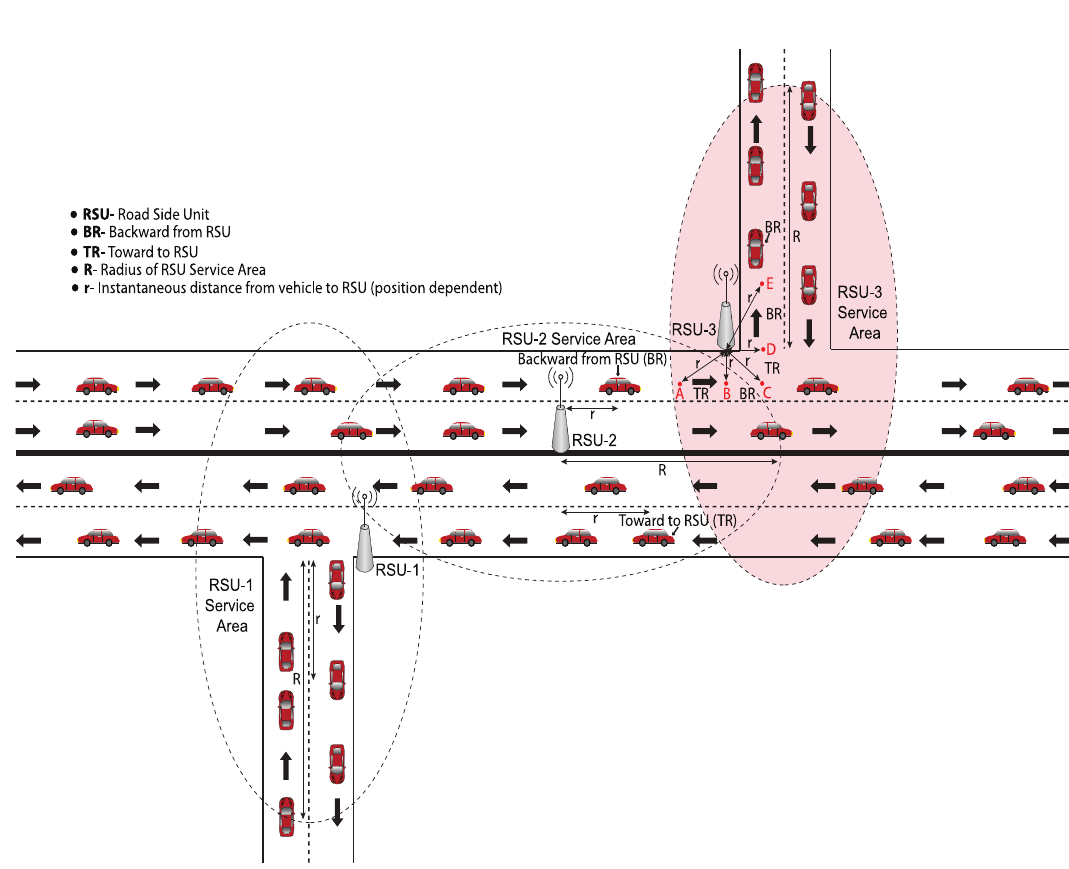
Figure 2. A V2I based VANET